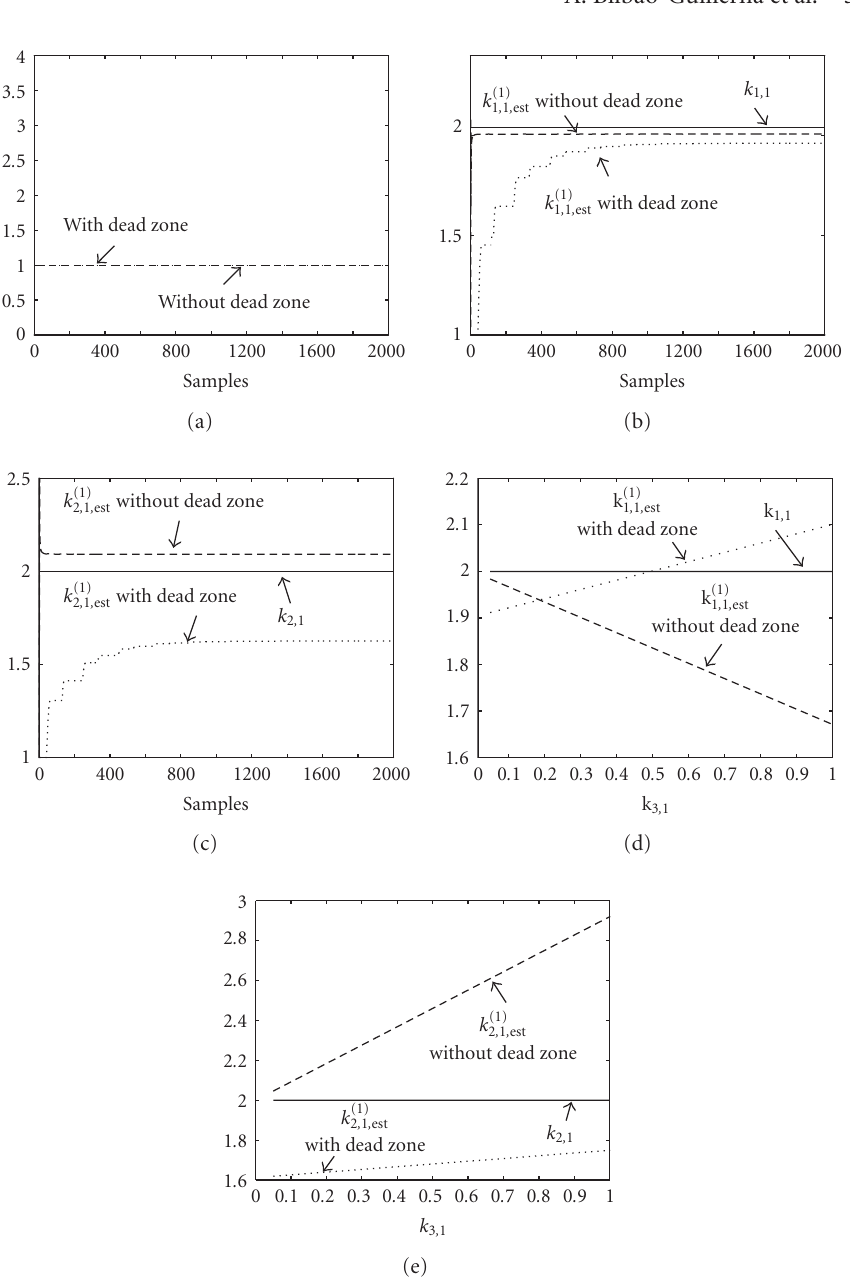
Figure 5.2. (a) Active reduced-order estimation model. (b) Identification of the parameter k (1) 1,1 . (c) Identification of the parameter k (1) 2,1 . (d) Identification of the parameter k (1) 1,1 as a function of the un- modeled dynamics magnitude. (e) Identification of the parameter k (1) 2,1 as a function of the unmodeled dynamics